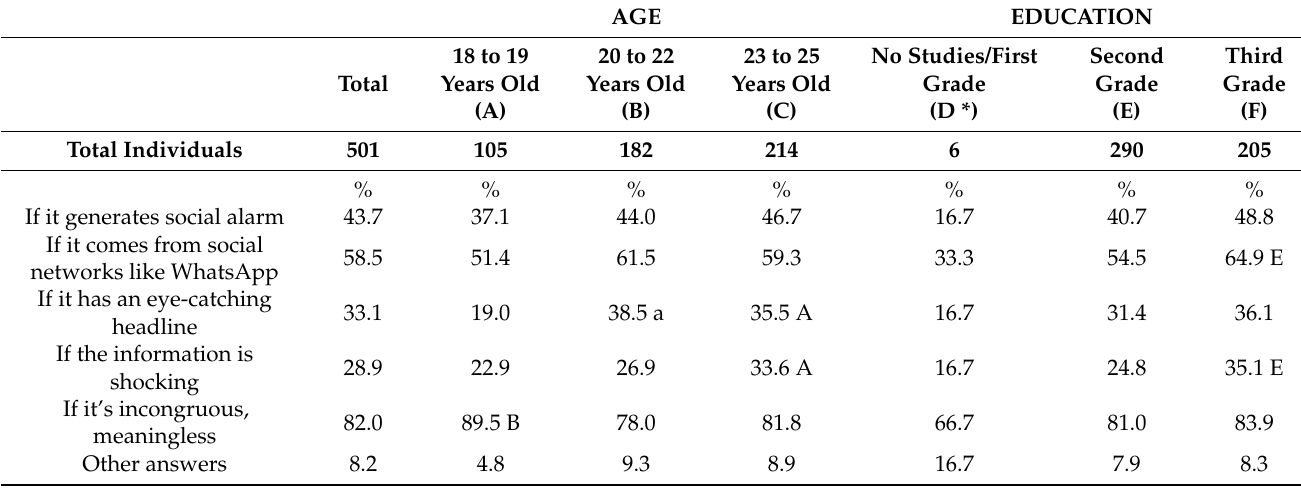
Table 10. Question 5: What makes you think that a news item is fake? You can mark multiple answers. (Show list with all items together) (Rotate order of items).